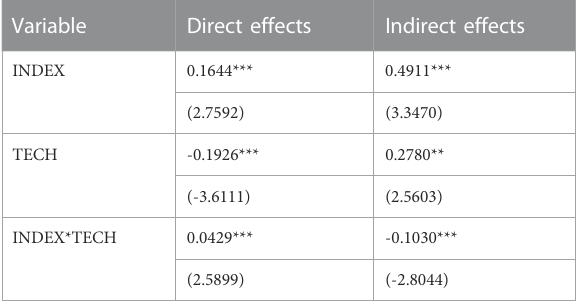
TABLE 8 Spatial effect decomposition of technological